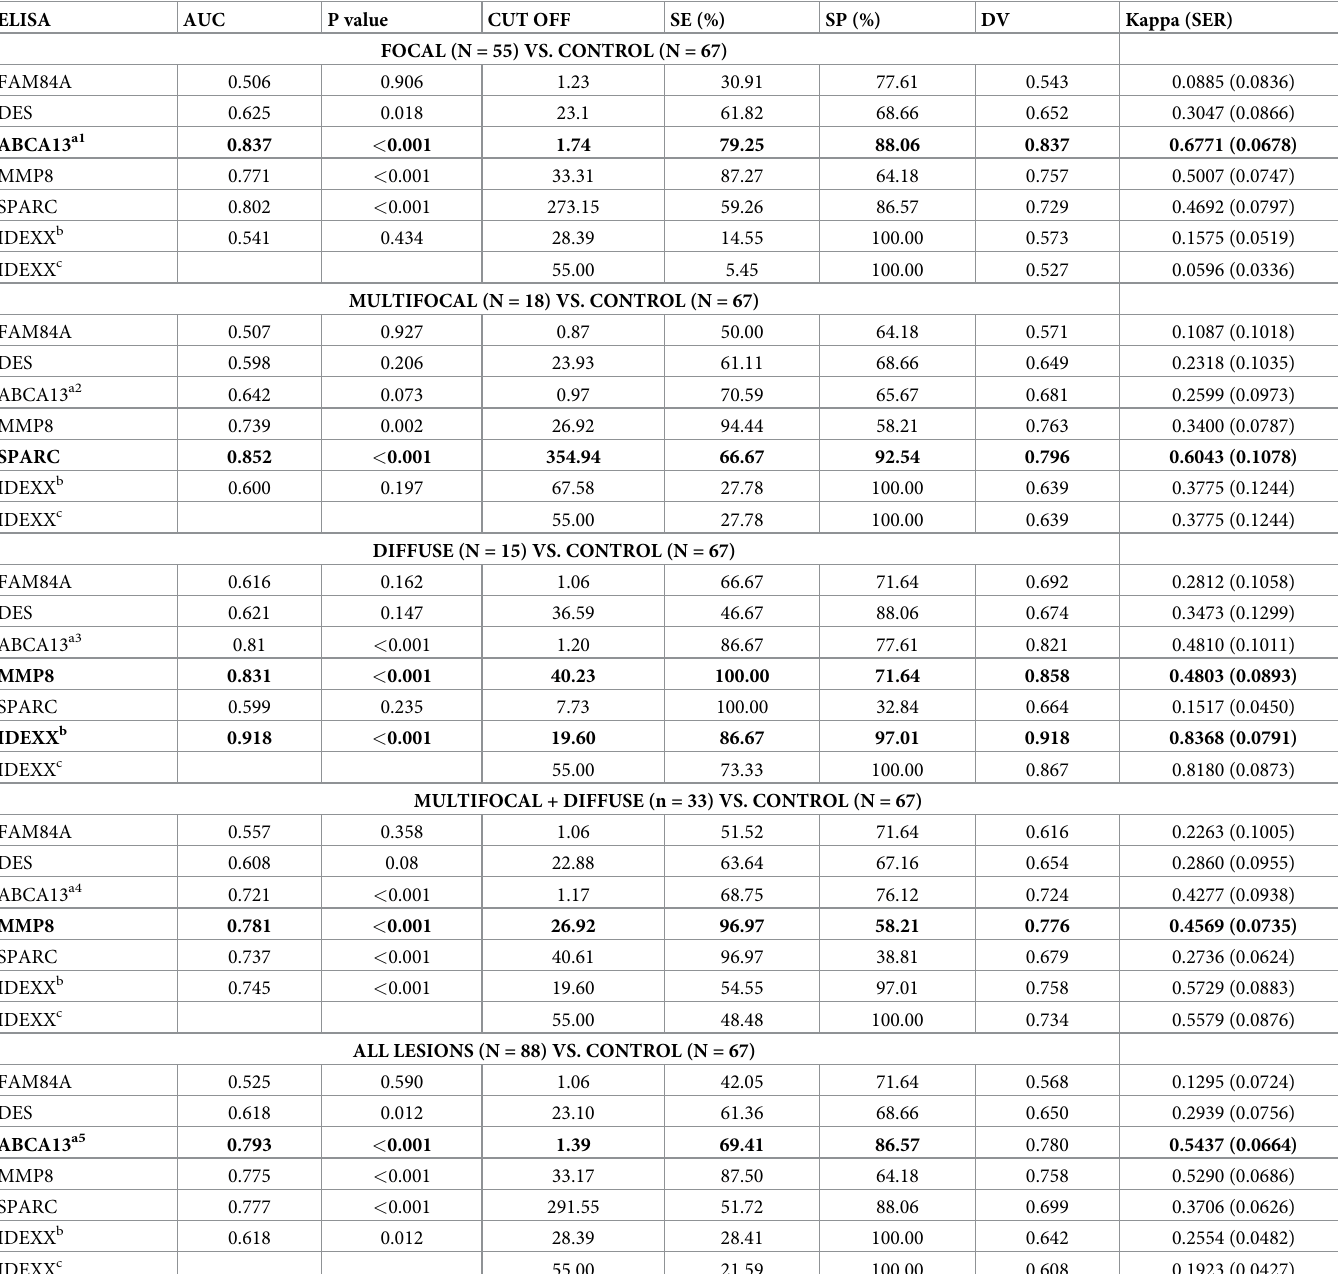
Table 3. Diagnostic performance of biomarker-based ELISAs for diagnosis of cattle with different types of PTB-associated histopathological lesions in their intesti- nal tissue. ELISA